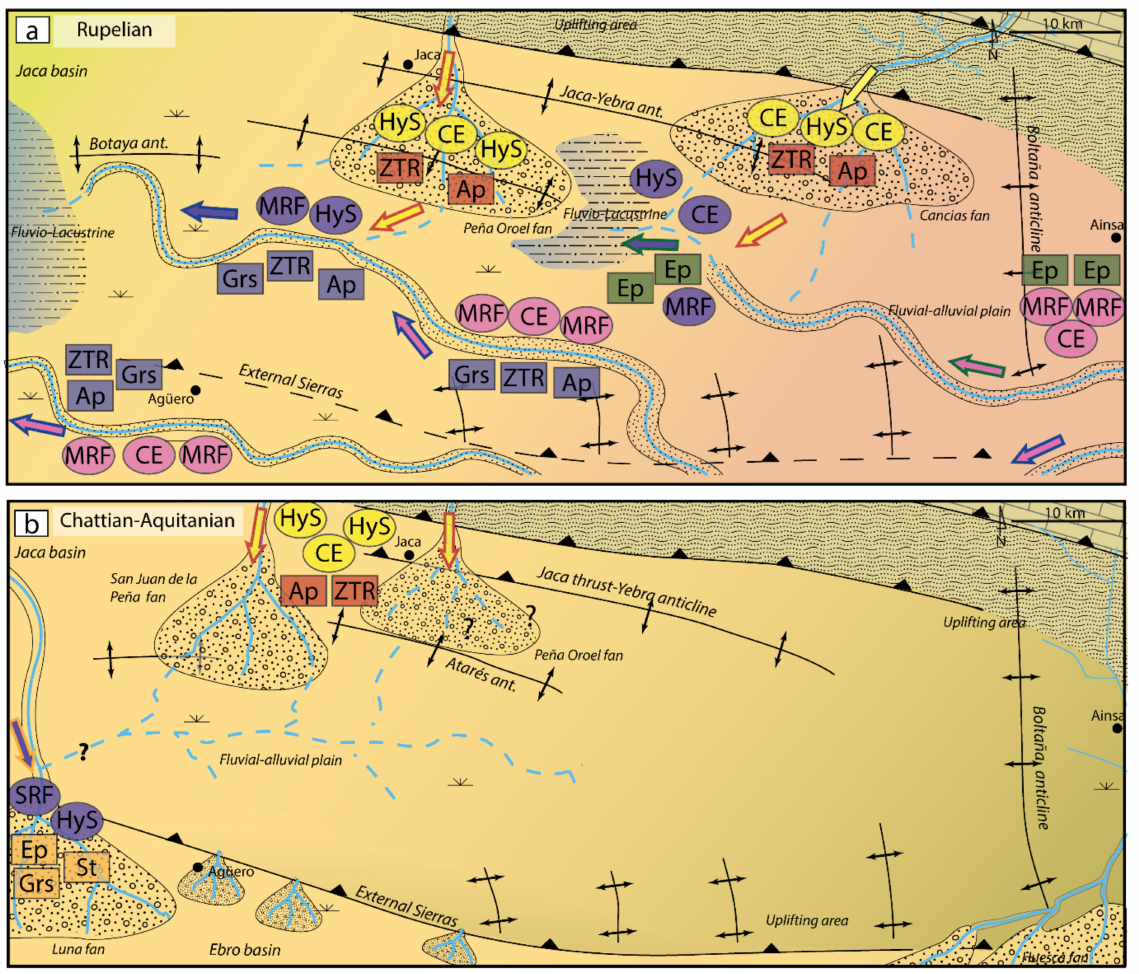
Figure 10. Paleogeographic scheme of the Jaca and Ebro basins during Rupelian–Aquitanian times. ( a ) Rupelian. ( b ) Chattian–Aquitanian. Circles and squares highlight distinct components. MRF: meta- morphic rock fragments, SRF: sedimentary rock fragments, CE: carbonate extrabasinal grains, HyS: hybrid sandstone rock fragments, Ap: apatite, ZTR: ZTR, Ep: epidote, Grs: grossular, Ttn: titanite, St: staurolite. Circle colors correspond to petrofacies described in Figure 4. Square colors correspond to heavy-mineral suites described in Figure 7. Arrows indicate petrofacies (fill) and heavy-mineral suite (stroke). Reconstruction of the maps based on Hirst and Nichols, Puigdef à bregas, Friend et